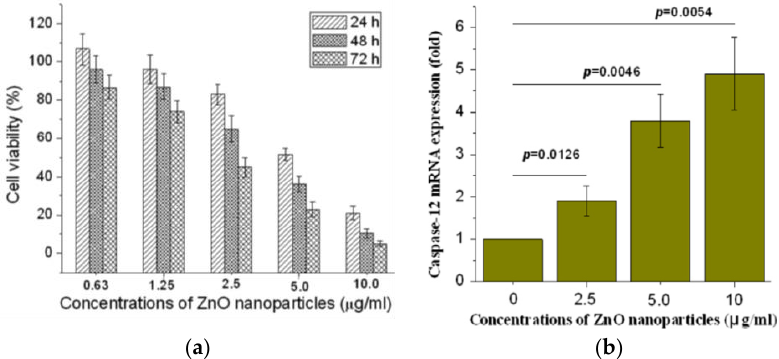
Figure 19. ( a ) Cell viability of RGC-5 cells vs ZnO NPs concentrations. The results are presented as mean ± standard deviation of three independent experiments (n = 3). ( b ) Real-time quantitative PCR analysis of caspase-12 gene expression in RGC-5 cell treated with ZnO NPs concentrations of 2.5, 5.0 and 10.0 µg/mL. The results are expressed as mean ± S. E. of three independent experiments. Reproduced from [123] with permission of Elsevier.